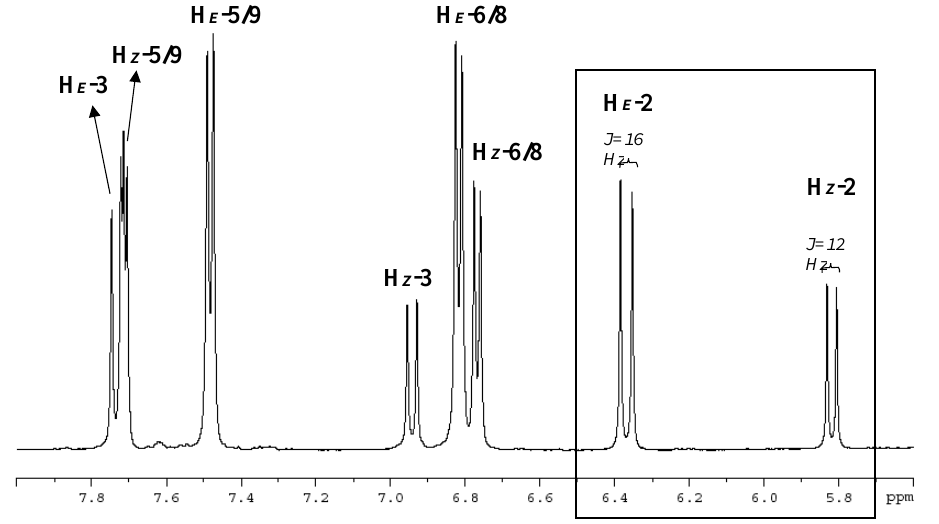
Figure 5. Aromatic region of 1 H-NMR spectrum of F2 in CD assignments are indicated in Figure 4 and characteristic vicinal H-H coupling constants in the insert